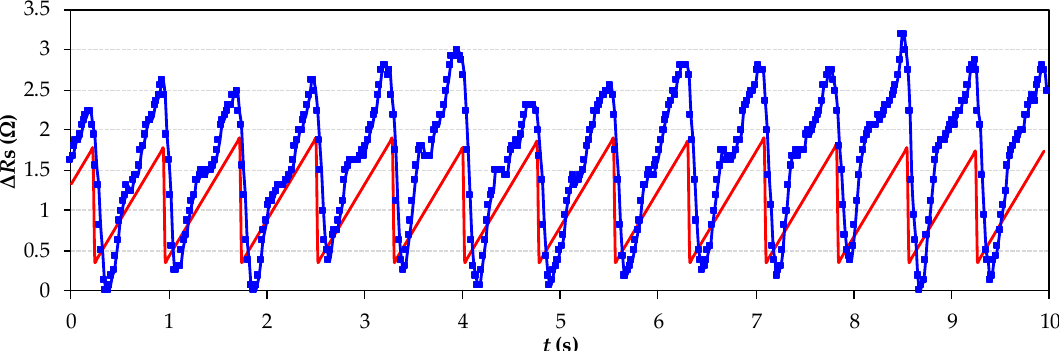
Figure 5. Experimental heartbeat signal reconstruction and HR measurement by the downward slope shown in each signal beat (the MCU implements the algorithm in real time).